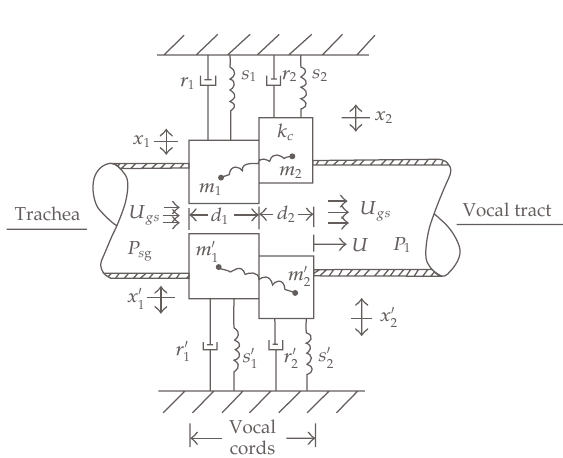
Figure 4: Two-mass model of the vocal fold (cid:4) 20 (cid:5)